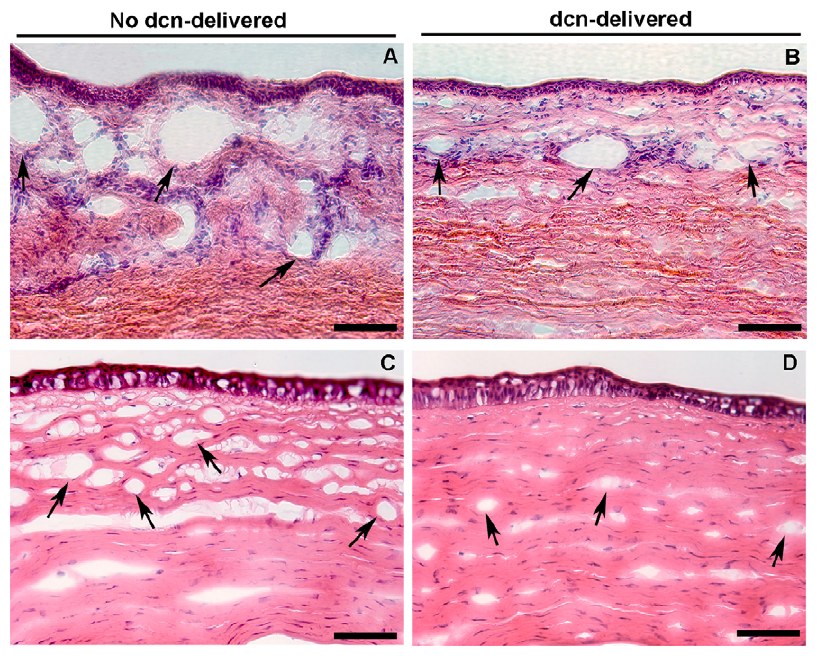
Figure 4. Representative H&E staining images showing anti-angiogenic efficiency of decorin gene therapy in rabbit corneas. The decorin-delivered rabbit corneas (B and D) showed a statistically significant (p , 0.01) reduction in vasculature area, density, and blood vessels number, length and diameter compared to control (no decorin-delivered) rabbit corneas (A and C) collected 14 days after VEGF implantation. The images shown in panels A and B are from the corneal sections obtained from the peripheral region of the cornea closer to the limbus whereas the images shown in panels C and D are from the corneal sections proximal to the VEGF pellet. Scale bar denotes 100 m m. dcn=decorin.